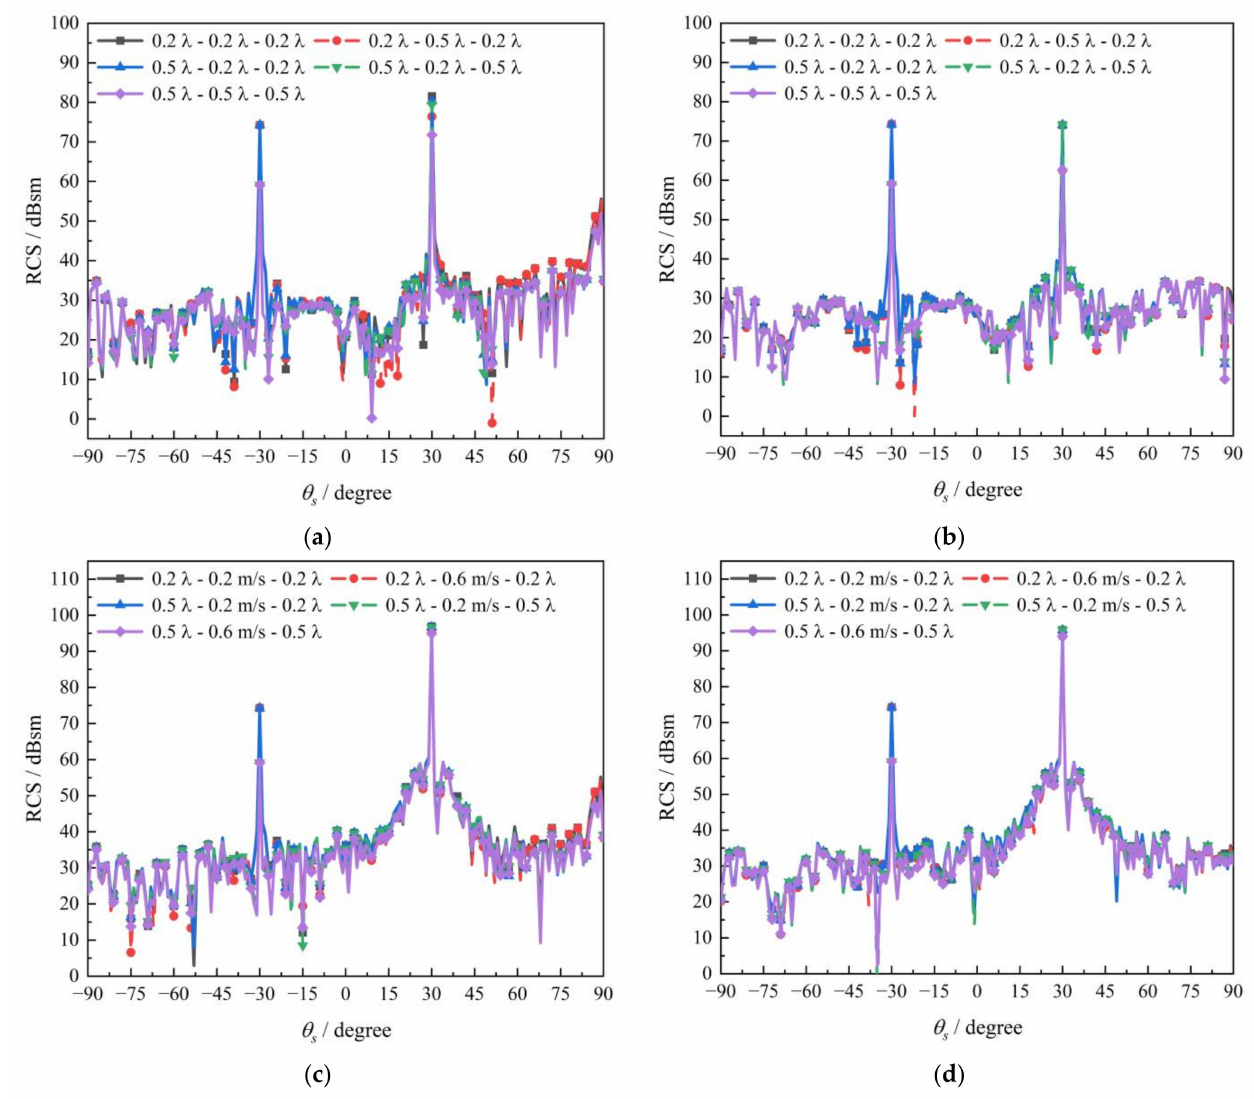
Figure 16. Bistatic RCS simulation results: ( a ) canyon, HH-polarization; ( b ) canyon, VV-polarization; ( c ) valley, HH-polarization; ( d ) valley, VV-polarization. Similarly, the peak values at θ s = − 30 ◦ are mainly affected by the roughness of the right slope. Comparing the blue curve and green curve, when the roughness of the right slope increases from 0.2 λ to 0.5 λ , while the roughness of the left slopes and the bottom remains unchanged, the peak value at θ s = − 30 ◦ decreases from 74.2975 dBsm to 59.0459 dBsm, while the peak values at θ s = 30 ◦ change less 1